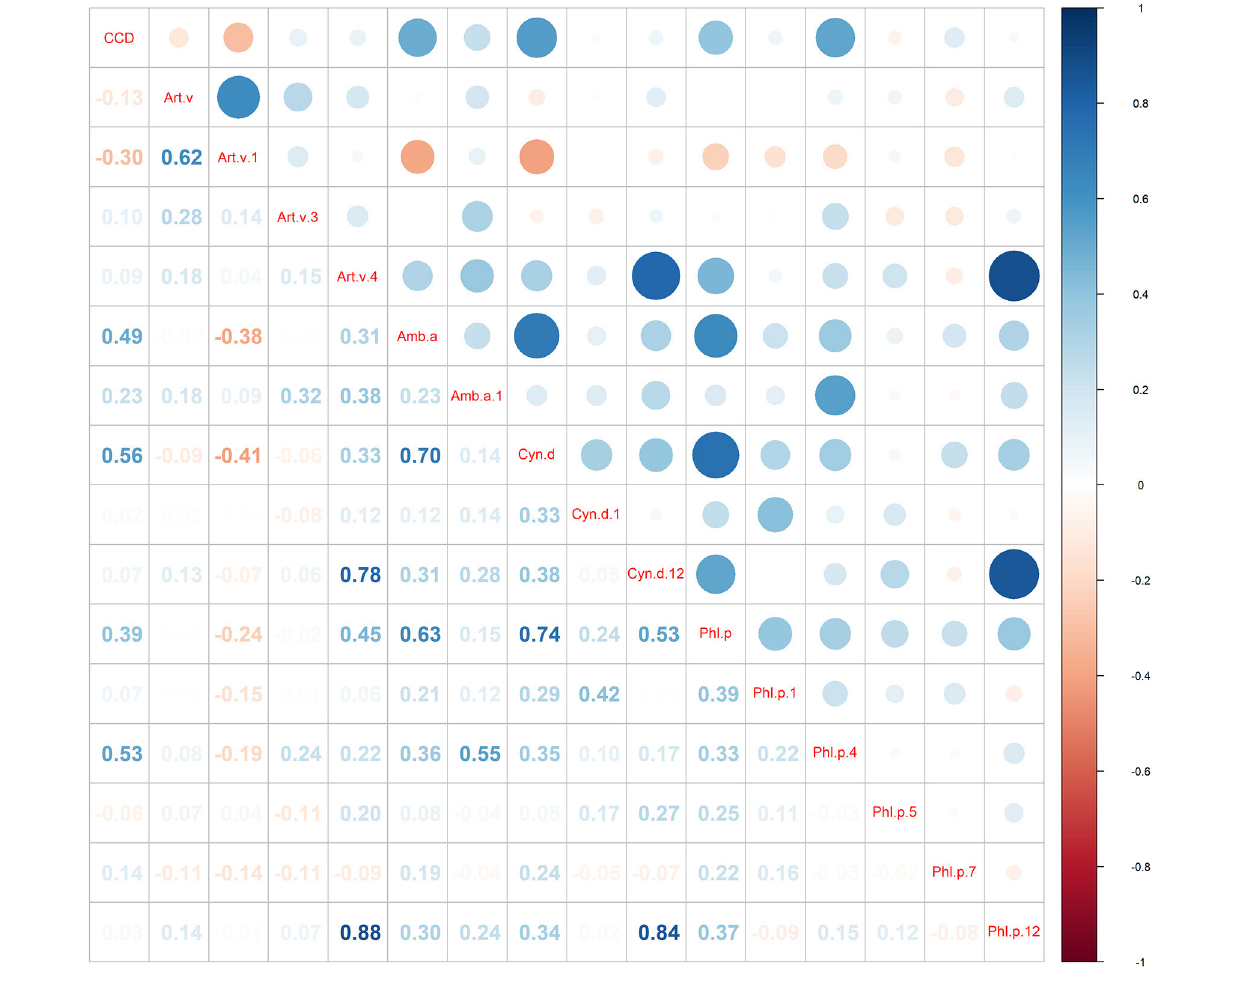
FIGURE 3 | Sensitization patterns identified by latent class analysis. Class proportions shown in the figure are computed based on most likely class